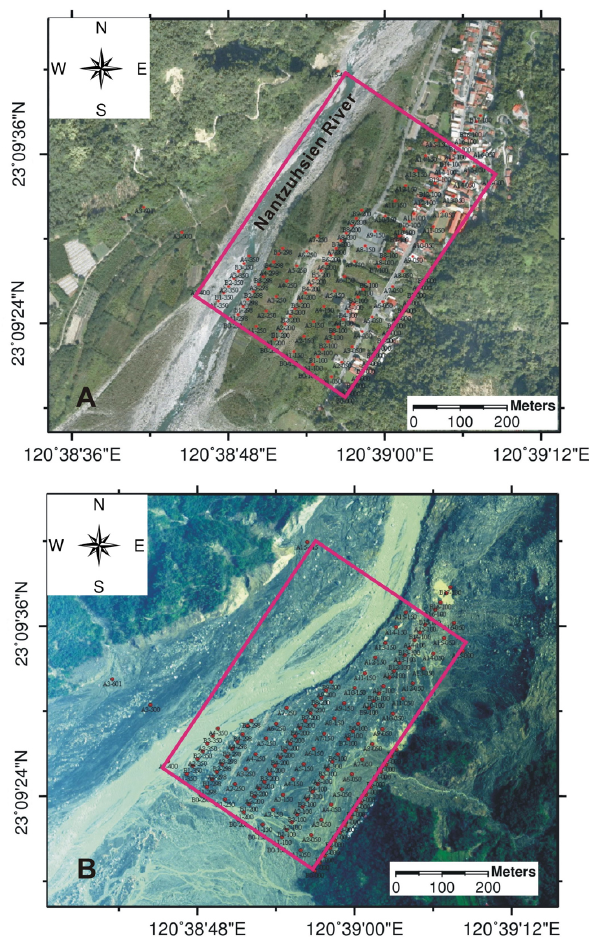
Fig. 2. Aerial photographs of Siaolin Village taken (a) before and (b) after Typhoon Morakot. Red dots are leveling benchmarks for positioning. Purple rectangles in each photo indicate the areas of the magnetic survey. Note that the main course of the Nantzuhsien River was slightly diverted to the east after Typhoon Morakot.